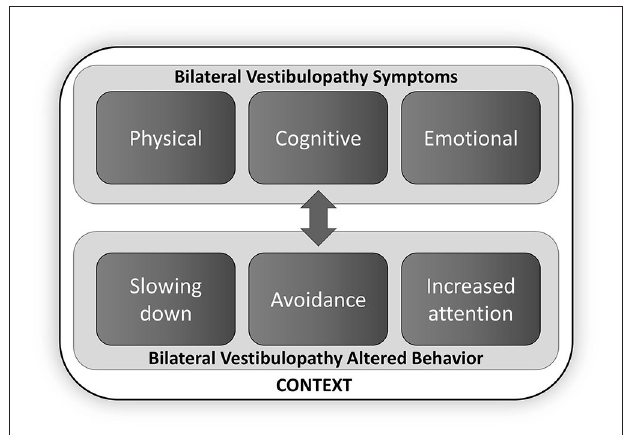
FIGURE 1 | Conceptual framework of the Bilateral Vestibulopathy Questionnaire (BVQ) [adapted from Lucieer et al. (6)]. The spectrum of BVP symptoms is categorized in three different domains (the physical, cognitive, and emotional domain), which can lead to context-specific behavioral changes. Double arrow indicates the interrelation between